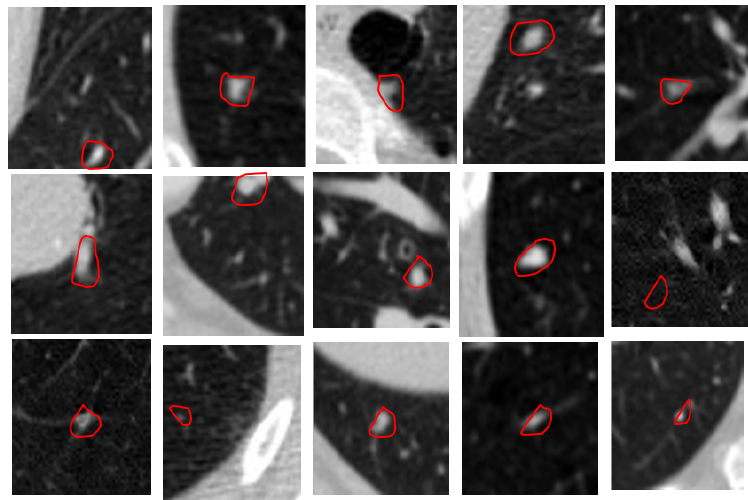
Figure 4. Selected nodule candidates from the features of the lung CT